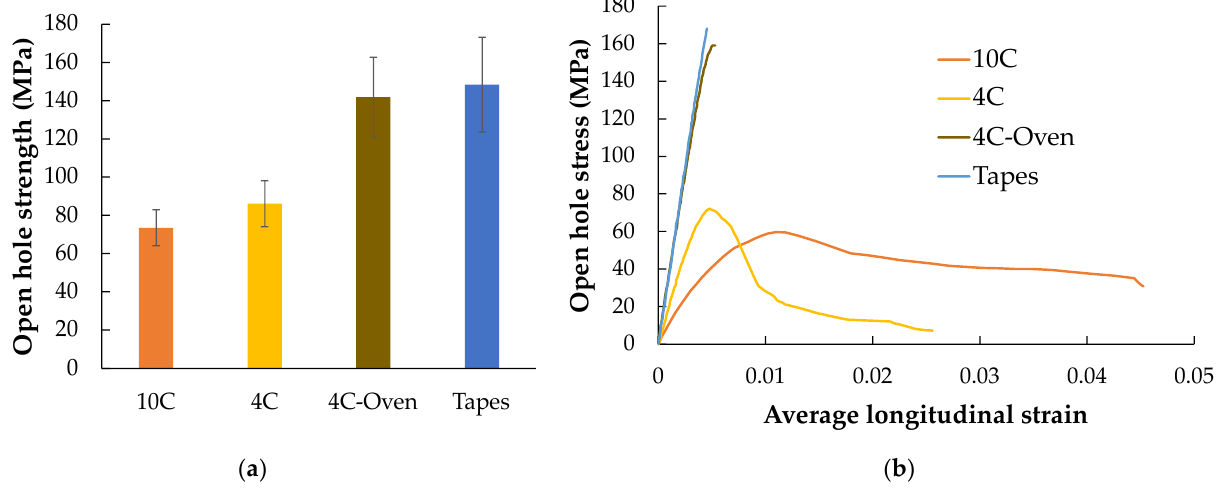
Figure 11. ( a ) Open-hole strength of different sample types; ( b ) open-hole stress versus average longitudinal strain curves of each sample type showing different failure behaviours.